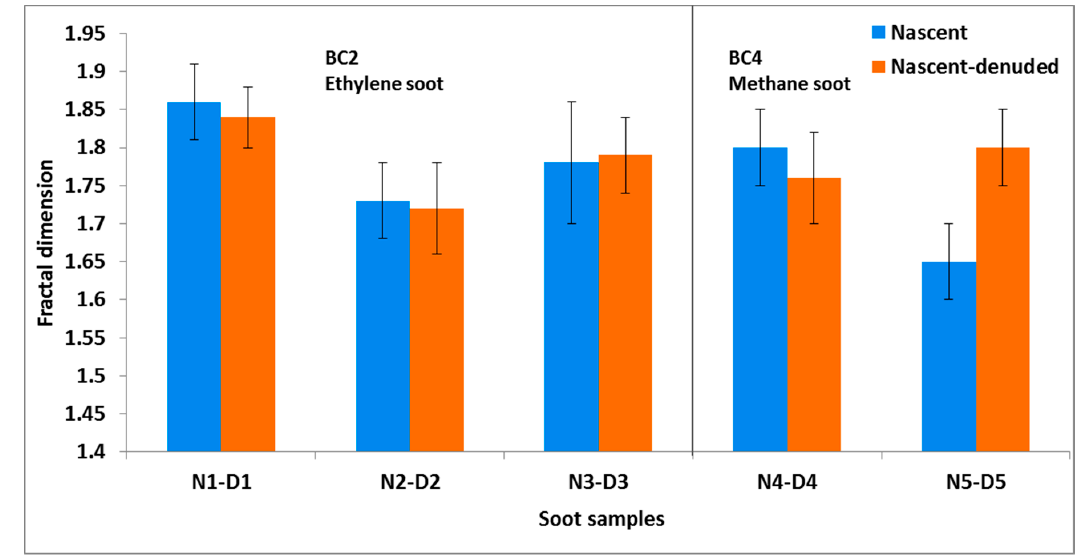
Figure 4. Fractal dimension of nascent (in blue) and nascent-denuded (in orange) soot pairs of different mobility sizes. The error bars represent the standard errors.